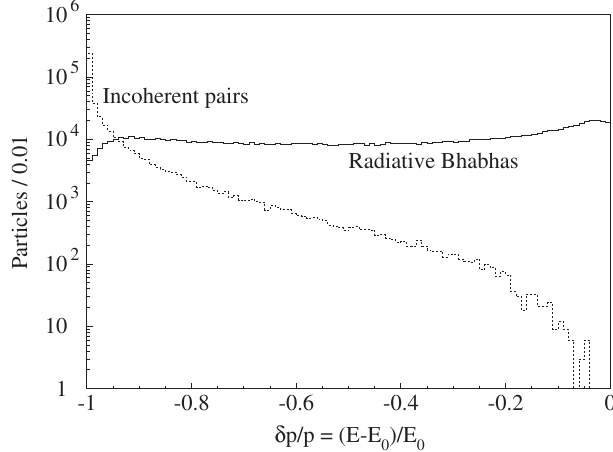
FIG. 4. Horizontal and vertical angular distributions of the particles of the e þ e (cid:1) coherent pairs with the same charge as the CLIC disrupted beam (Cohplus) and with the opposite charge (Cohminus), obtained with GUINEA-PIG using Gaussian incoming beams and normalized to one bunch.